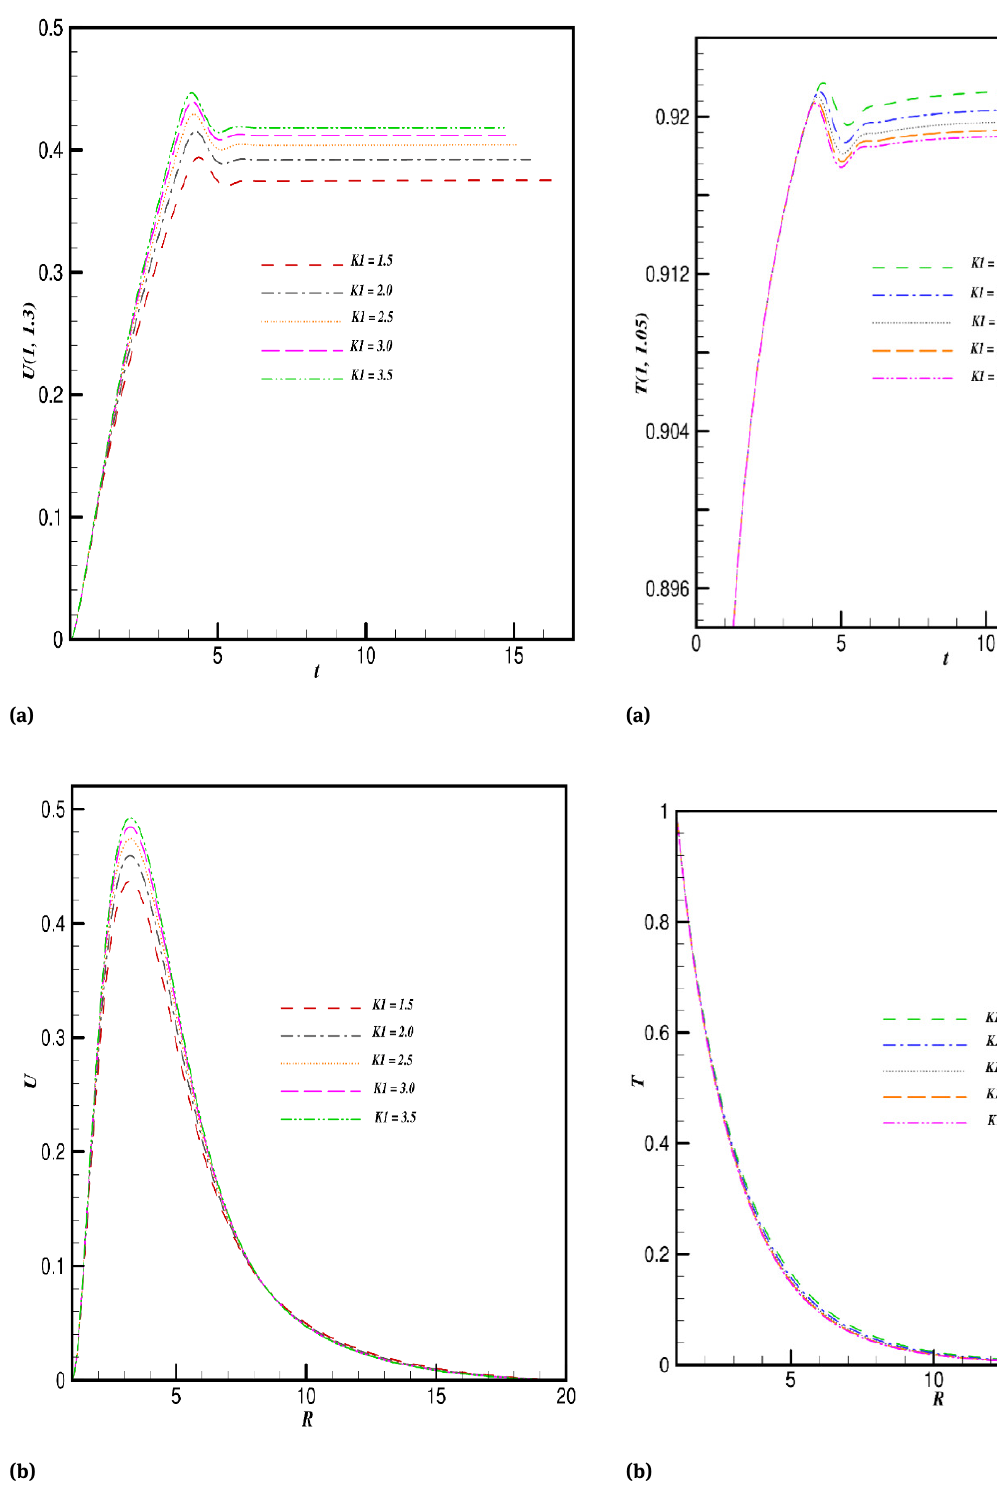
Figure 7: ( a ) Transient and ( b ) Steady state temperature profiles with fixed Sc = 0.6 , Pr = 0.7 , Bu = 1.0 , Kr = −0.2 , Nr = 1.0 , M = 0.2 , Ec = 0.1